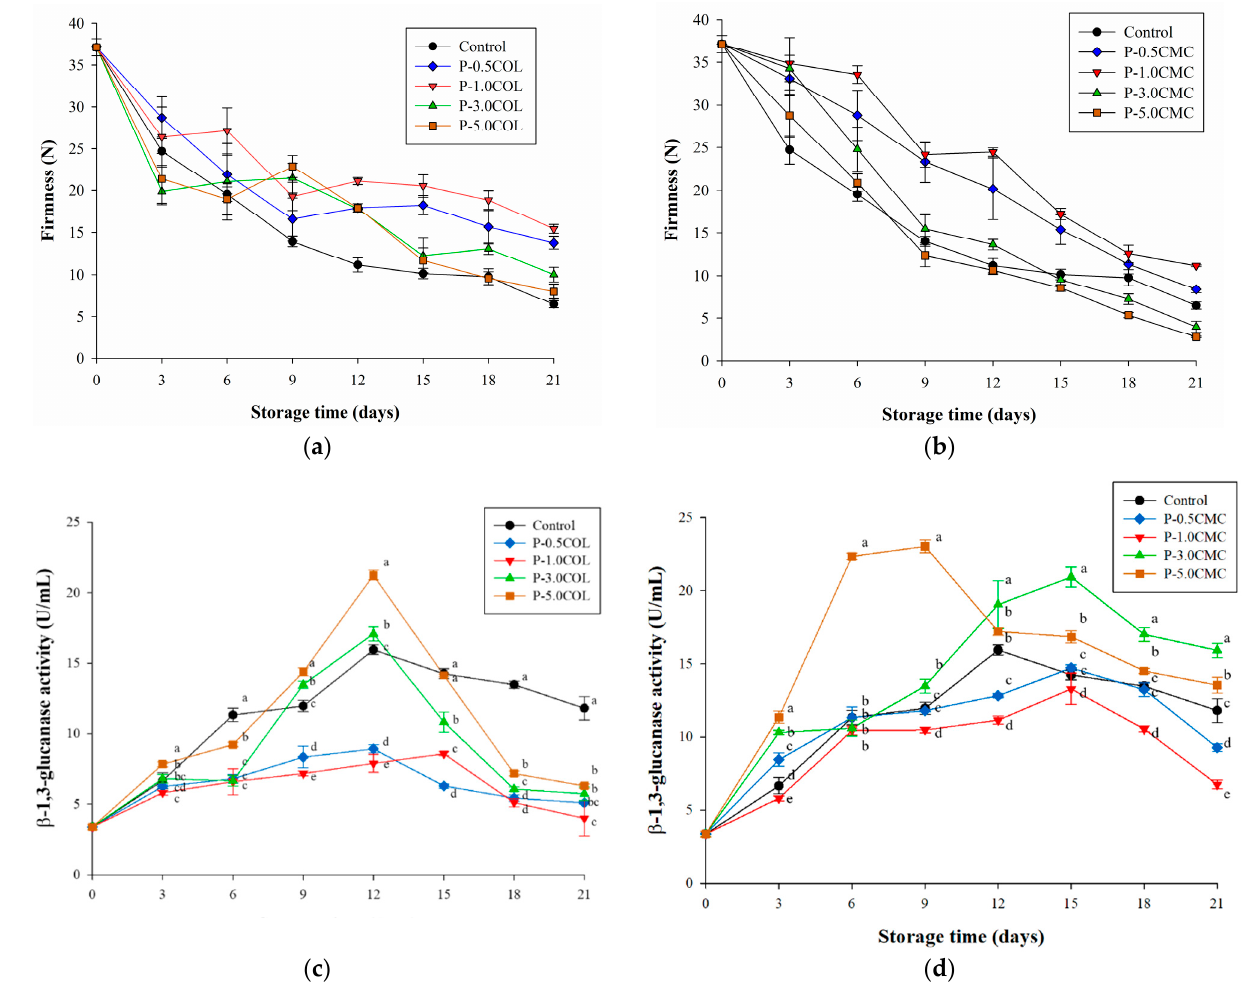
Figure 2. Effects of different packaging films on the structure of A. bisporus during storage at 4 ◦ C for 21 days. ( a ) Firmness